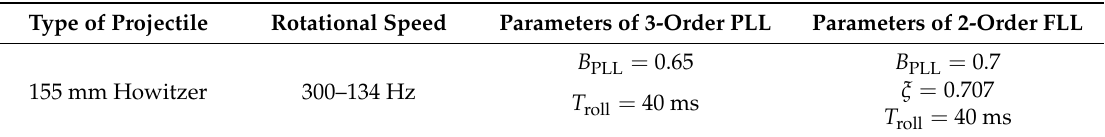
Table 3. Optimized parameters.